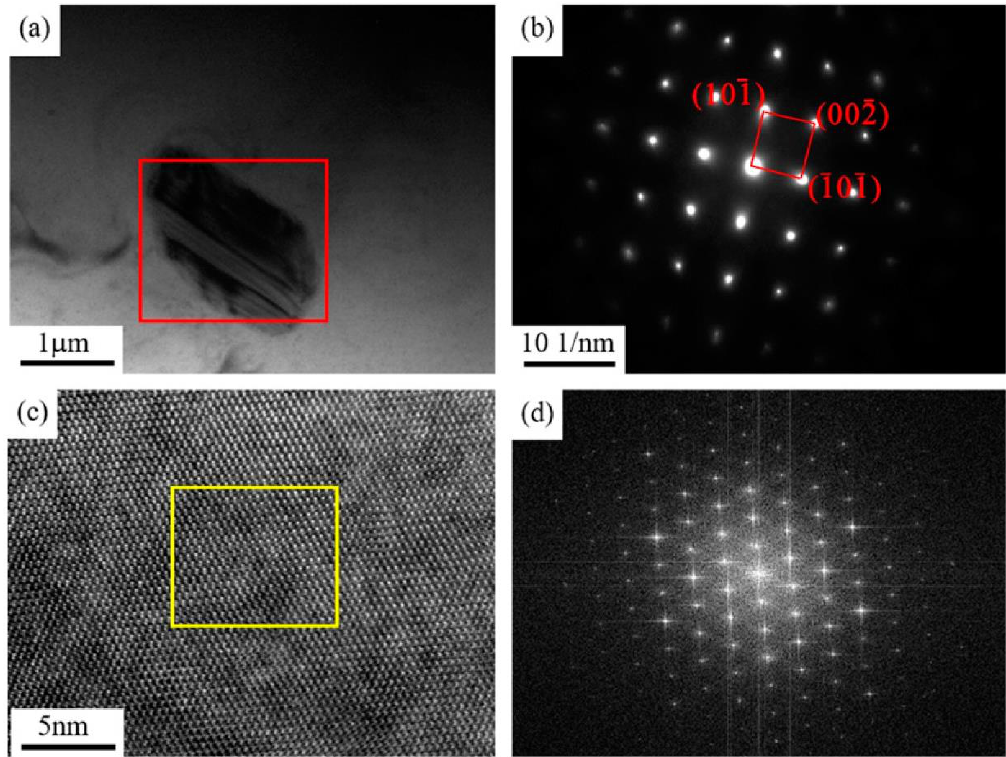
Figure 9. The TEM images of the solution-treated sample of the Cu–6Ni–6Sn–0.6Si alloy: ( a ) bright-field image, ( b ) selected-area electron diffraction, ( c ) high-resolution image, ( d ) Fourier transform.